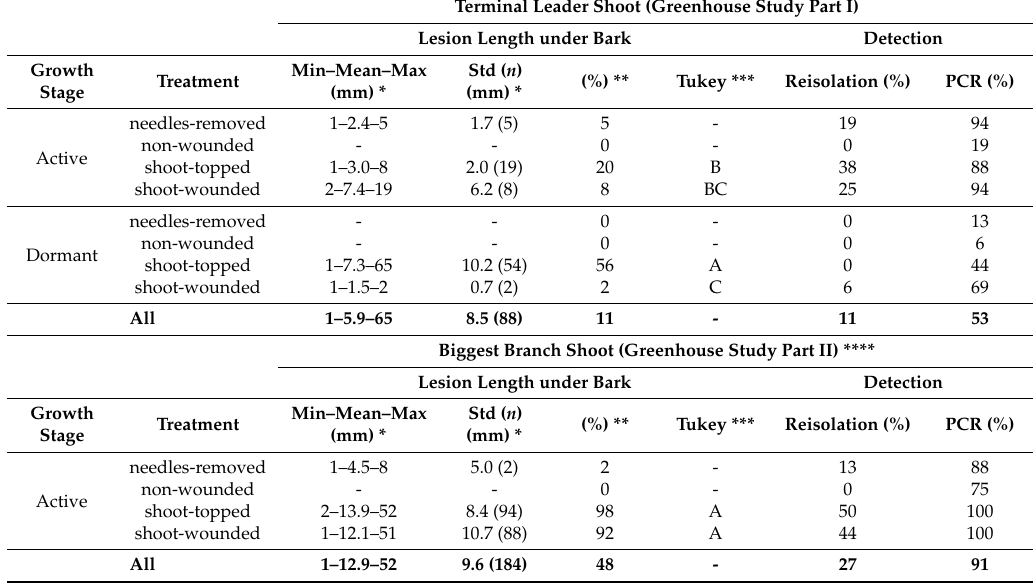
* The minimum, mean, maximum, standard deviation and sample size for lesion length under bark measured in millimeters were based on plants with a measurable lesion length under bark (that is, excluding all the plants